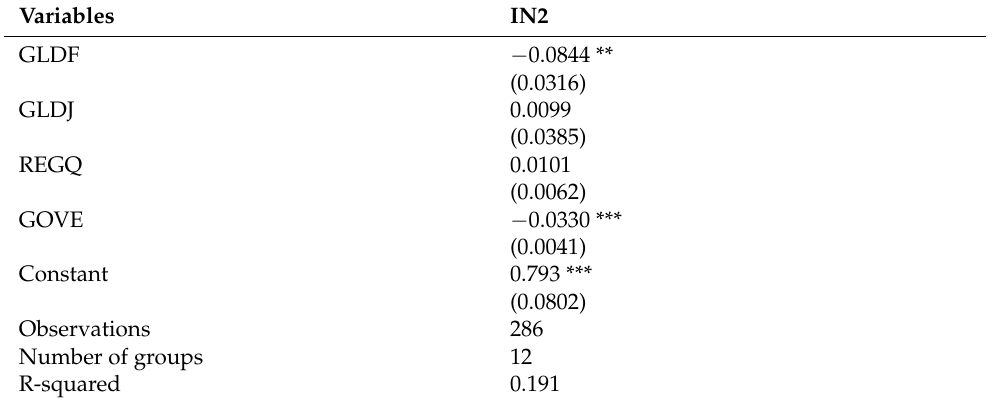
Table 13. Model 3. DV: Income Share of the Top 10%